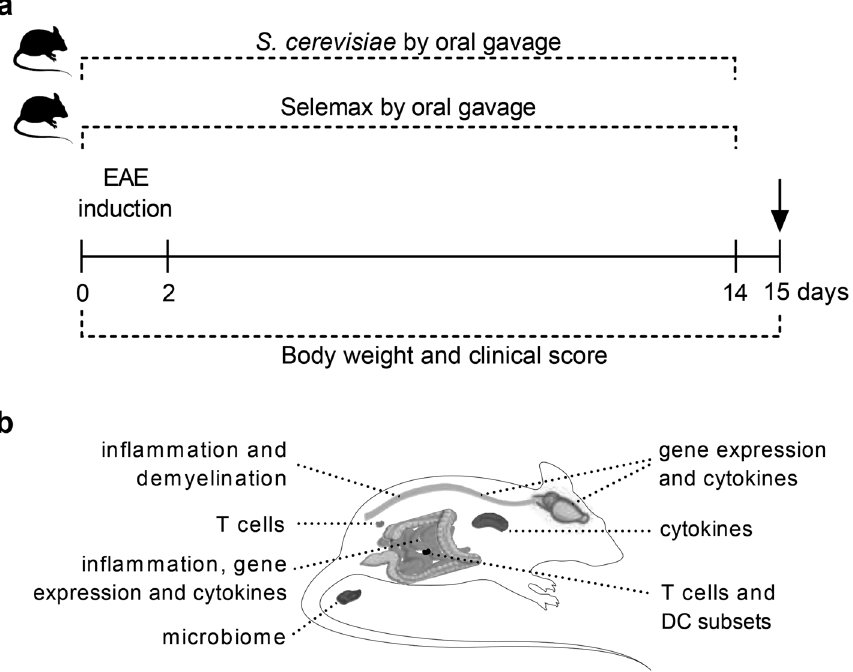
Figure 1. Experimental design. C57BL/6 mice received daily oral doses of Saccharomyces cerevisiae or selenium-enriched yeast (Selemax) for 14 days starting on EAE induction ( a ). Body weight and clinical score were assessed daily for 15 days. On the 15th day, which corresponded to the acute disease phase, fresh stools were collected for metagenomic sequencing and the animals were then euthanized (arrow). Samples from gut- brain axis and peripheral lymphoid organs were collected to evaluate immunological parameters ( b ). The mRNA expression and cytokine levels were assessed on CNS (brain plus spinal cord) whereas inflammatory infiltration and demyelination were assessed on lumbar spinal cord. Inflammatory infiltration, mRNA expression and cytokine levels were assessed on small intestine and the proportion of T cells and dendritic cells subsets were evaluated in mesenteric lymph nodes. Peripheral immunological parameters as T cell and cytokine levels were evaluated in inguinal lymph nodes and spleen, respectively. This figure was created using images from Servier Medical Art Commons Attribution 3.0 Unported License (https ://smart .servi er.com) and image was modified with Adobe Photoshop